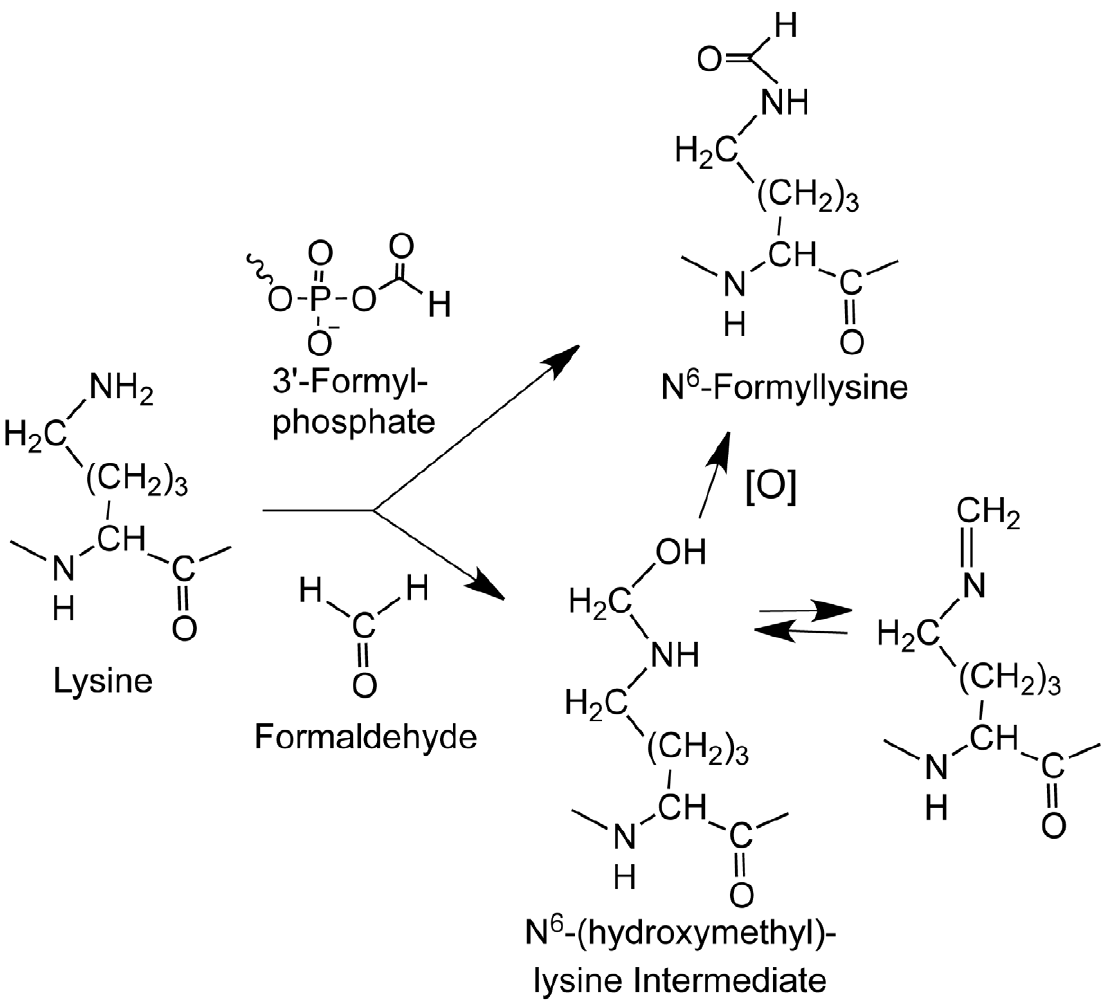
Figure 1. Sources of N 6 -formyllysine. The adduct can be generated in chromatin proteins from reaction of lysine with 3 9 -formylphosphate residue derived from 5 9 -oxidation of 2-deoxyribose in DNA or from reaction of lysine with endogenous or exogenous formaldehyde. Formaldehyde reacts with amines to give a carbinolamine intermediate (N 6 -(hydroxymethyl)-lysine) that is in equilibrium with a Schiff base and that is one oxidation state away from the formamide functional group of N 6